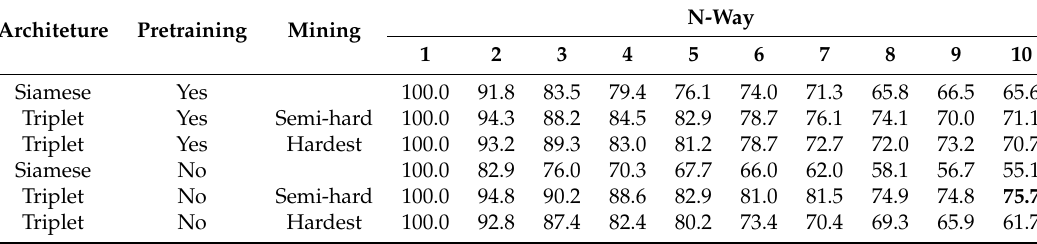
Table 3. The performance of each method for metric learning on the vehicle re-identification dataset, given by the one-shot classification accuracy. For each setup, 1000 one-shot classification tasks were evaluated on the test